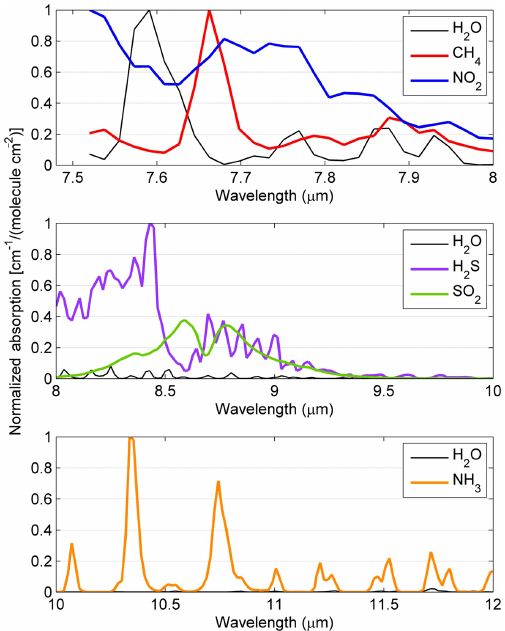
Figure 5. Normalized absorption spectra of H 2 O, CH 4 , NO 2 , H 2 S, SO 2 , and NH 3 extracted from the HITRAN 2012 database and con- volved to the HyTES spectral response functions displayed in dif- ferent wavelength ranges in the thermal infrared from 7.4 to